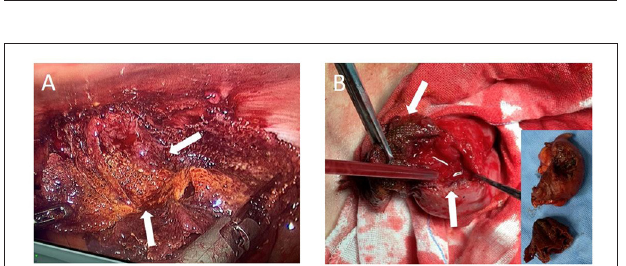
FIGURE 1 | Images of representative abdominal CT and gastrointestinal radiography. (A) Infectious lesions in the right groin area, sinus formation, and involvement of the adjacent ileum; (B) no obvious signs of contrast agent leakage on barium meal imaging of the whole digestive tract; (C) 2 months after the surgery, the lesion in the right groin area is absorbed and narrowed, the sinus tract is unclear, and part of the intestinal canal in the abdominal cavity showed a metal anastomosis.